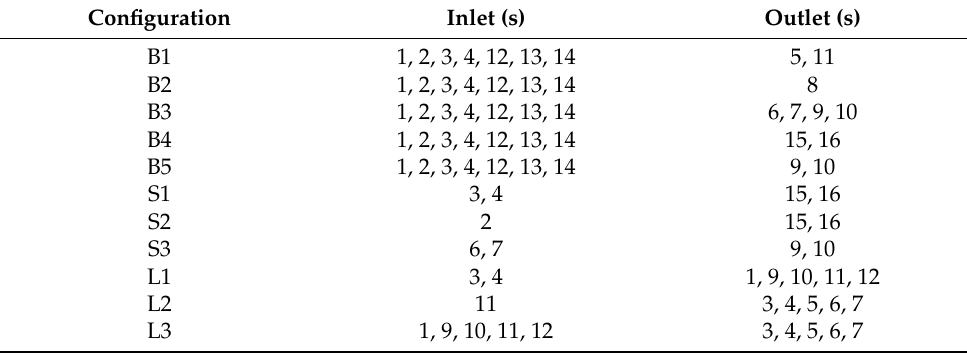
Figure 3. Constructed PVT heat exchanger indicating valve locations: ( a ) Schematic diagram, ( b ) Photograph of the experimental PVT module. Table 2. Description of each of the heat exchange configurations